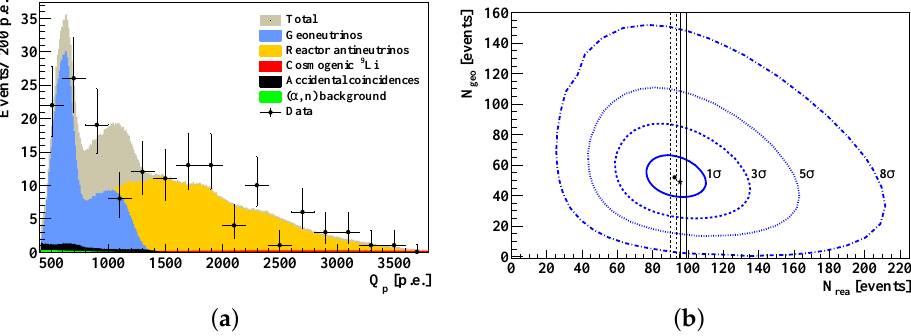
Figure 15. Results of the analysis of 154 golden IBD candidates. ( a ) Spectral fit of the data (black points with Poissonian errors) assuming the chondritic Th/U ratio. The total fit function containing all signal and background components is shown in brownish gray. Geoneutrinos (blue) and reactor antineutrinos (yellow) were kept as free fit parameters. Other non-antineutrino backgrounds were constrained in the fit. ( b ) The best fit point (black dot) and the contours for the 2D coverage of 68, 99.7, (100–5.7 10 − 5 ) %, and (100–1.2 10 − 13 ) %, (corresponding to 1, 3, 5, and 8 σ , respectively), × × for number of geoneutrinos (N geo ) versus number of reactor antineutrinos (N rea ), assuming Th/U chondritic ratio. The vertical lines mark the 1 σ bands of the expected reactor antineutrino signal (solid-without “5MeV excess”, dashed-with “5MeV excess”). For comparison, the star shows the best fit performed assuming the 238 U and 232 Th contributions as free and independent fit components. From